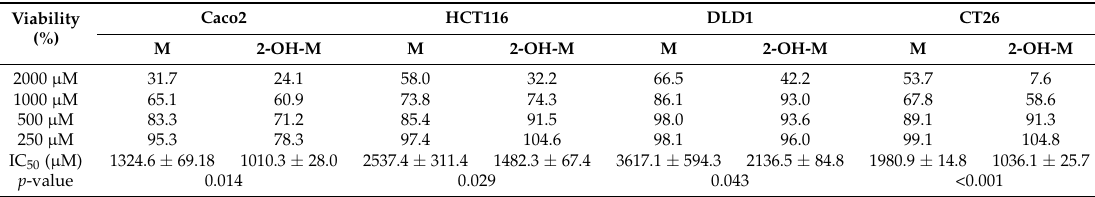
Table 1. IC 50 values of melatonin and 2-hydroxymelatonin.